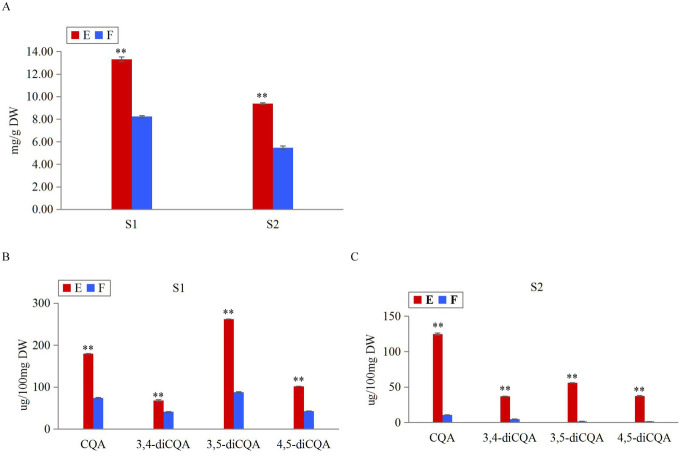
Measurements of TP and CGA contents between genotypes E and F at stages S1 and S2.(A) Measurements of TPC in genotypes E and F at stages S1 and S2. (B) Measurements of CGA monomers in genotypes E and F at S1. (C) Measurements of CGA monomers in genotypes E and F at S2. Error bars indicated ±SD (N = 3). ** T-TEST, P<0.01.